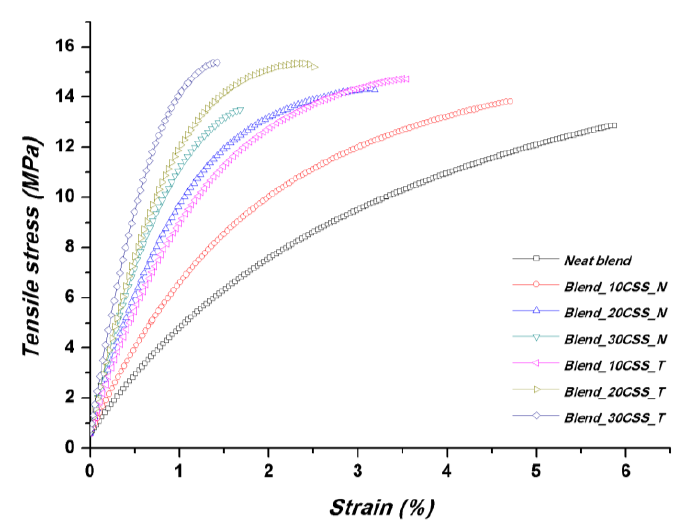
Figure 3. Typical stress–strain curves from tensile tests of PBAT/PHBV-based composites with non-compatibilized CSS. Table 2. Summary of tensile properties for PBAT/PHBV-based